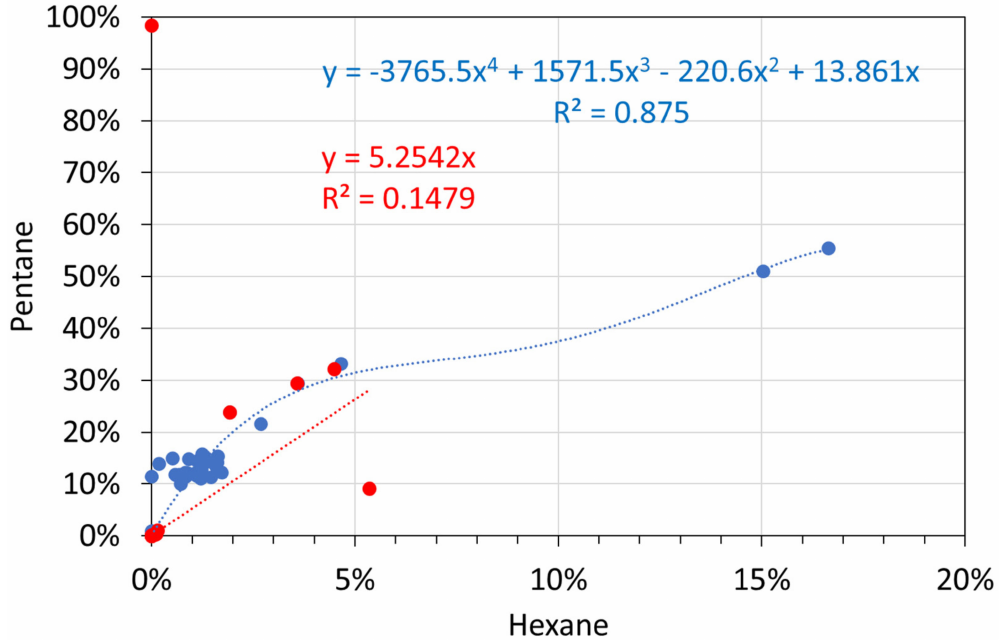
Figure A10. Molar alkane gas analyses: hexane vs. pentane. Blue circles: T ≤ 298 K; red circles: T = 348